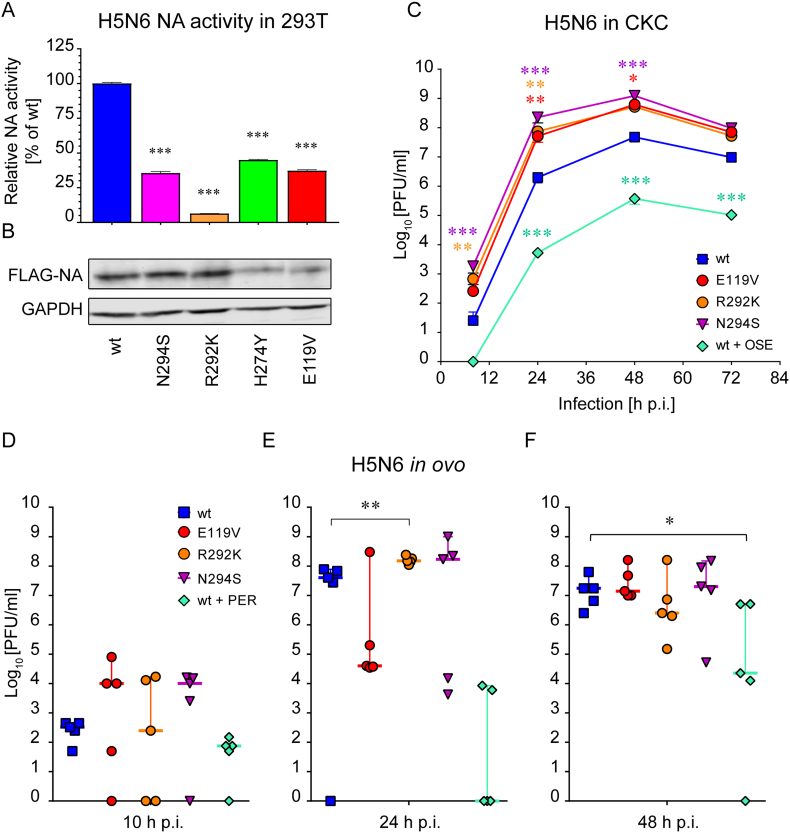
NA activity profile and growth kinetics of NAI-resistant H5N6 viruses in vitro and in ovo. (A) NA activities of H5N6 NAs. FLAG-tagged NAs (wt, E119V, H274Y, R292K and N294S) were expressed in HEK 293T cells, the NA activities were determined by MUNANA assay and normalised to protein expression levels. Data represent mean of 3 independent experiments ± SD (***p < 0.001). (B) Western blot analysis of H5N6 FLAG-NA expression in HEK 293T cells. Band intensities were quantified using ImageJ software and levels of protein expression were normalised to GAPDH. (C) Growth curve in vitro. cKC were infected with H5N6 NAI-resistant viruses as well as the corresponding wt at an MOI of 0.001. The supernatants were collected at the indicated time points and titrated by plaque assay. Graphs shown are representative of 2 independent experiments; each data point represents mean of 3 replicates ± SD (*p < 0.05; **p < 0.01; ***p < 0.001). (D–F) Growth curve in ovo. 10 day-old SPF embryonated hen's eggs were inoculated with H5N6 viruses at 100 PFU/egg. Allantoic fluid samples were collected at the indicated time points and titrated. Each data point represents a single egg; short horizontal line indicates the median with 95% CI, n = 5 (*p < 0.05; **p < 0.01). All virus-infected embryos were viable at 10 and 24 h p.i. and reached the terminal end point by 48 h p.i.